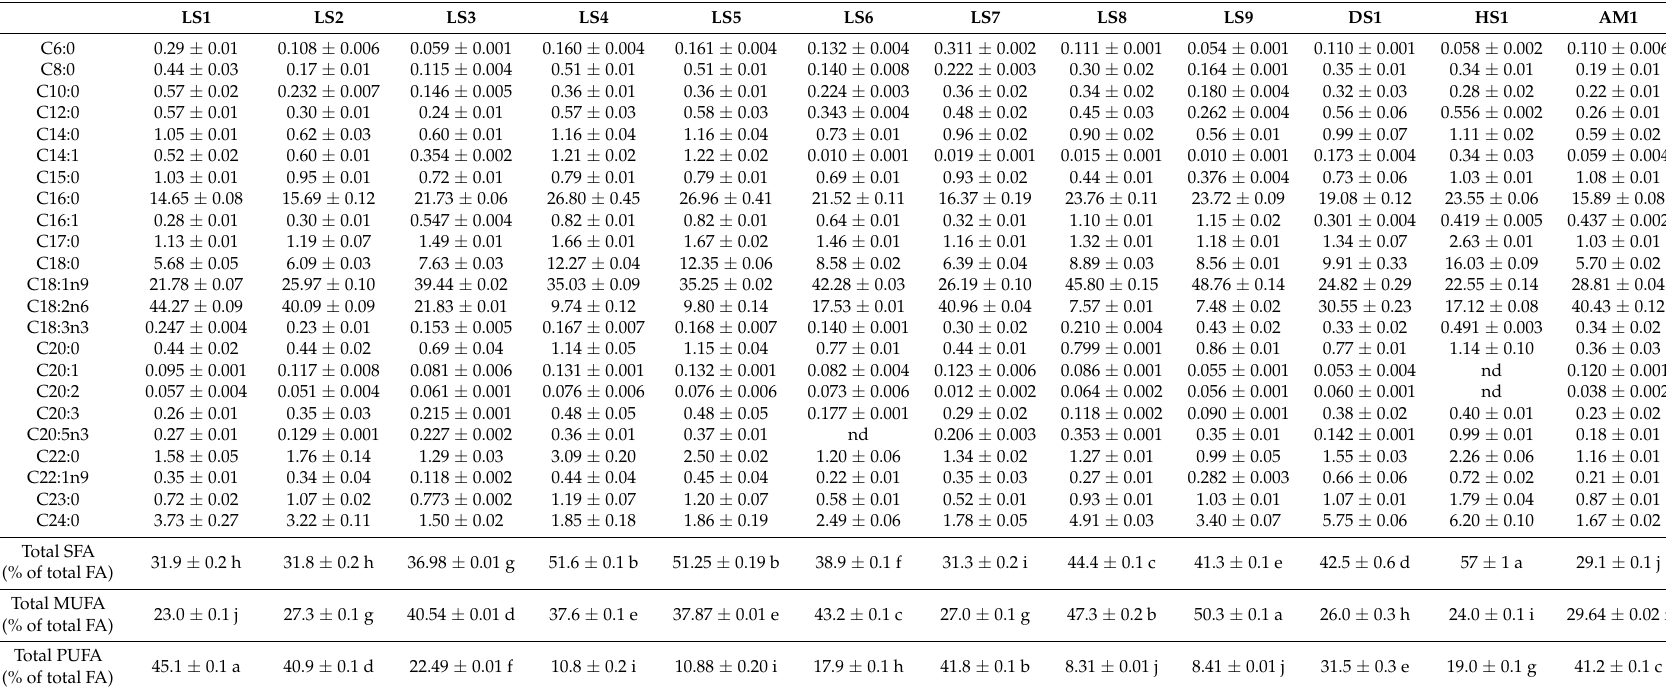
Table 2. Composition of fatty acids of the studied wild